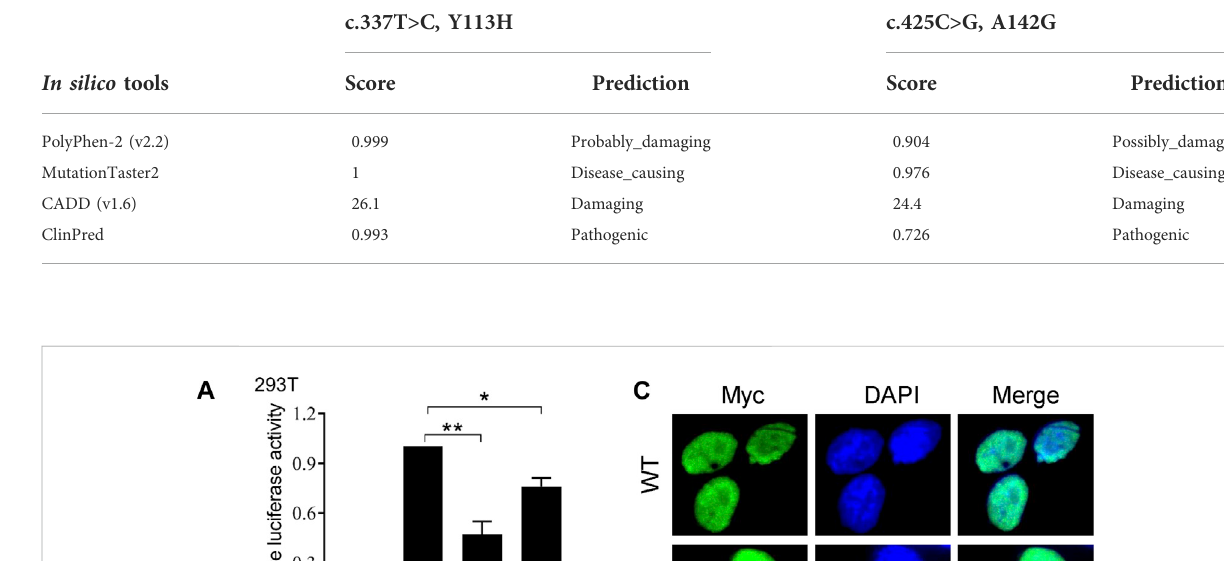
TABLE 2 Pathogenicity Predictions for Y113H and A142G variants of SOX11 .